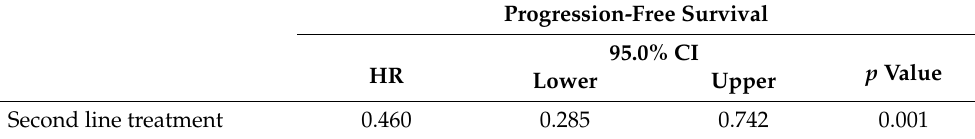
Progression-Free Survival 95.0% CI HR